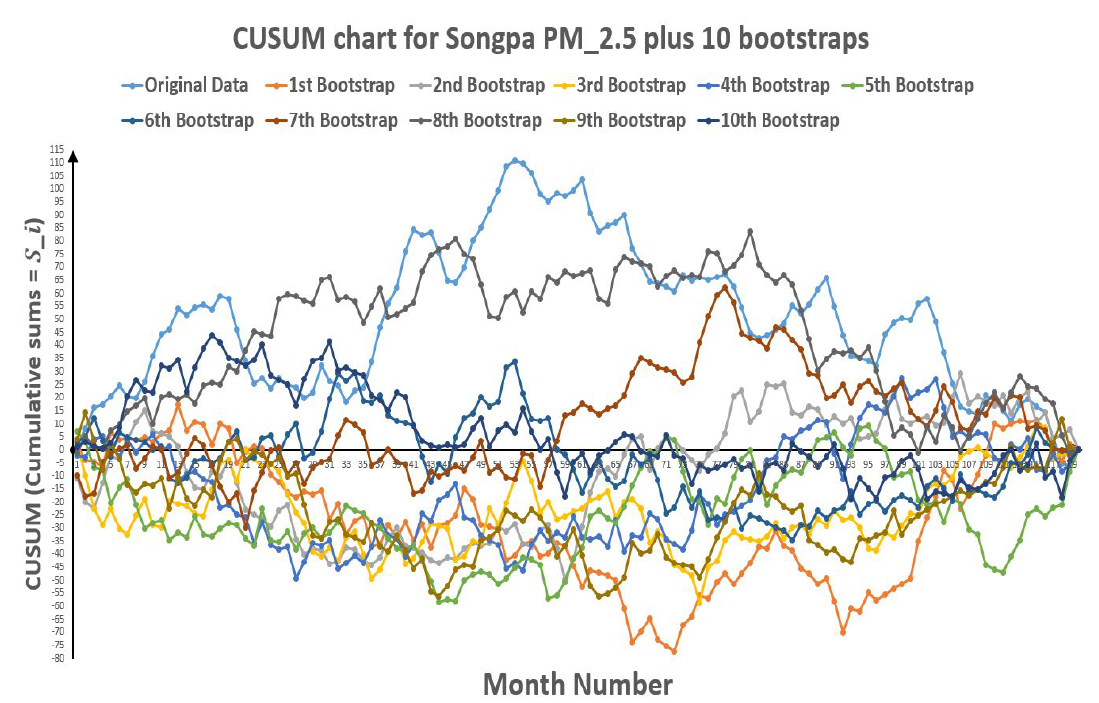
Figure 14. CUSUM chart for Songpa PM 2.5 plus 10 bootstraps (European Standards).